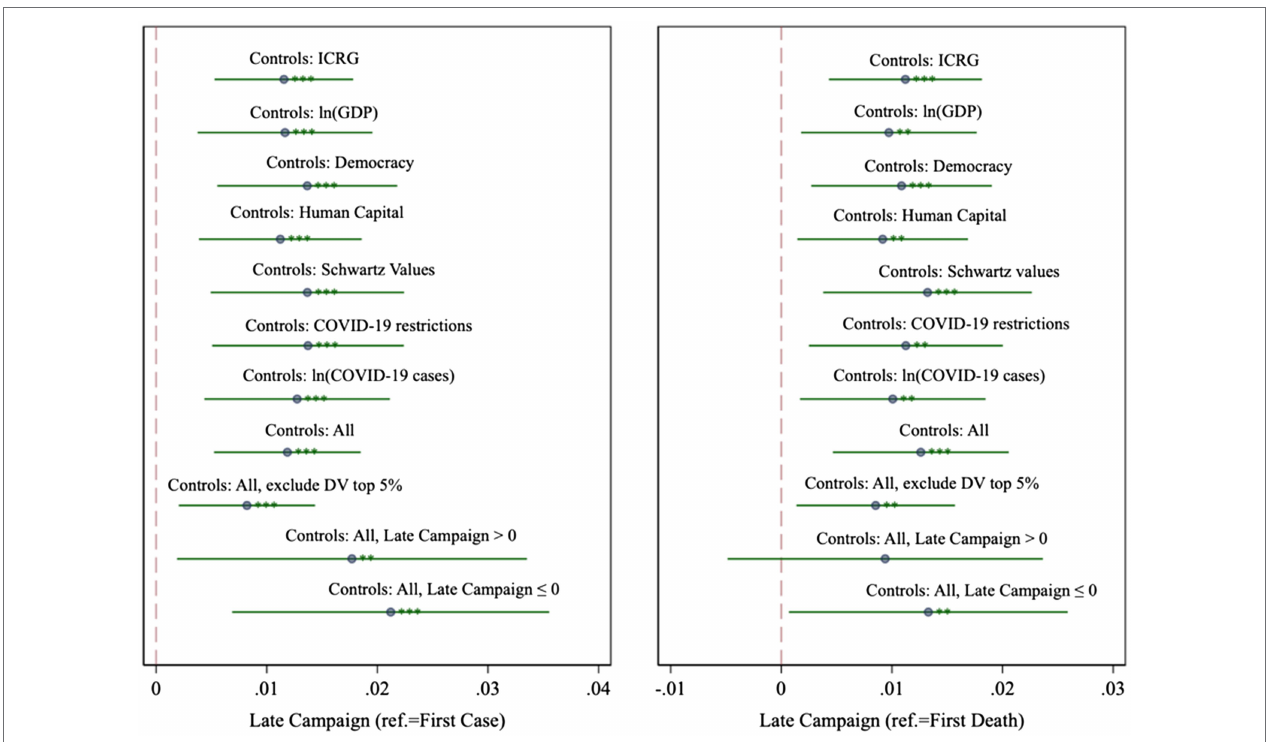
FIGURE 2 | Sensitivity analysis. ***, ** and * denote significance at the 1, 5 and 10% levels. Significance levels are reported on the confidence interval